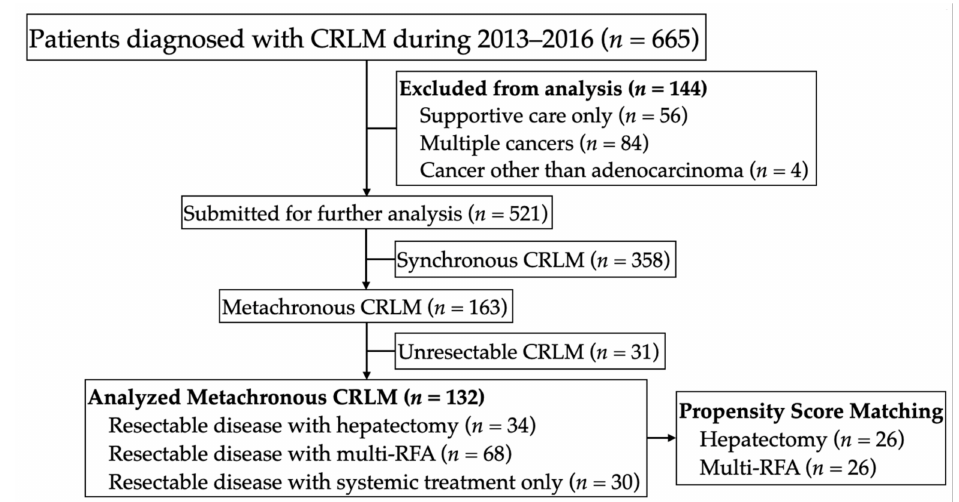
Figure 1. CONSORT flow diagram of the study